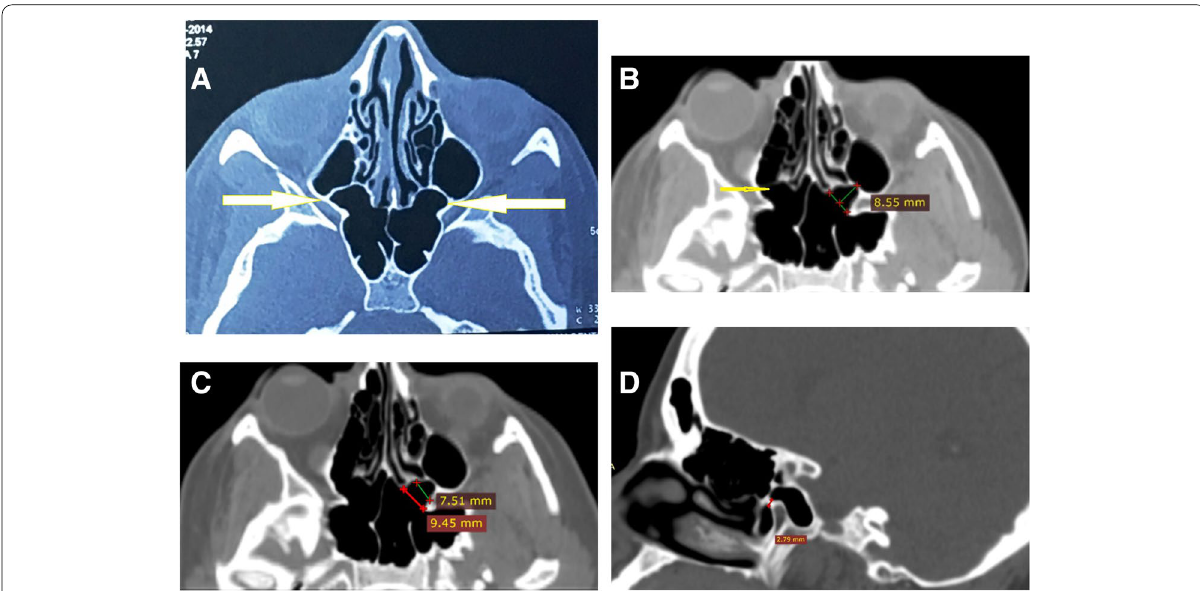
Fig. 1 A Axial MSCT showing bilateral retro‑maxillary sphenoid recesses directed anteriorly and laterally (arrows) with a bony septum between it and maxillary sinus. B Showing LT sided retro‑maxillary sphenoid recess and its antero‑posterior dimension, note that right air filled recess (arrow) related to ethmoid not maxillary sinus and considered as lateral pneumotization of sphenoid sinus. C Showing left retro‑maxillary sphenoid recess; recess width and its neck width. D Sagittal reformatted MSCT image (bone window) showing retro‑maxillary sphenoid recess directed downward with a bony septum separating recess from maxillary